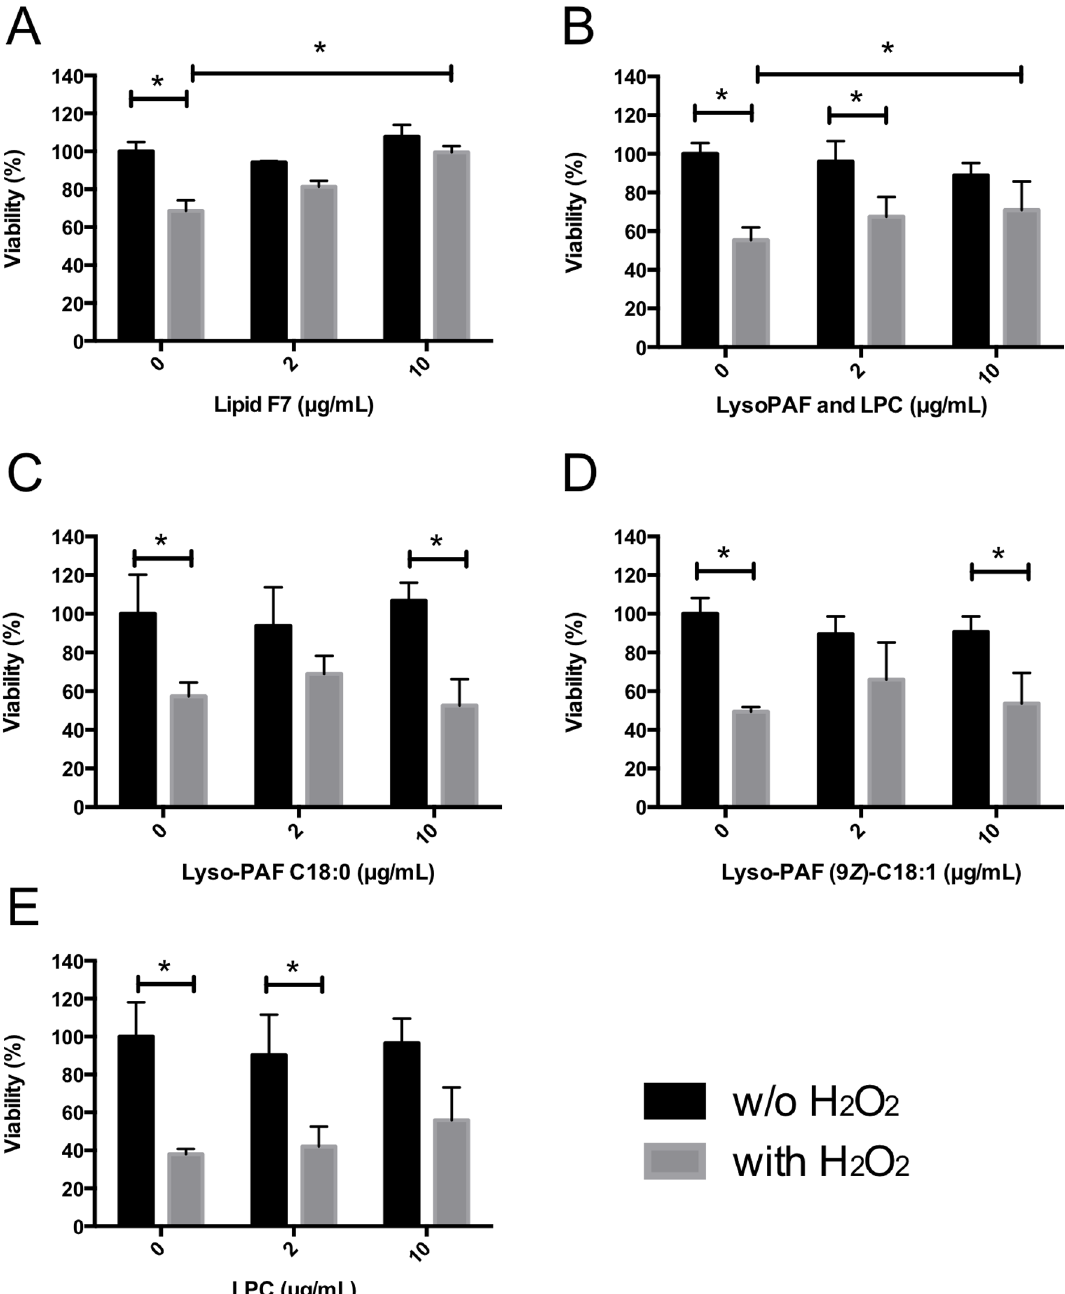
Fig 5. Viability of J774A.1 cells treated with LPC or Lyso-PAF. J774A.1 cells were preincubated with LPC or Lyso-PAF for 12 h, and H 2 O 2 was then added to the cells (25 μ M). After 12 h, cell viability was measured and is expressed as the mean viability ± standard deviation of triplicate experiments. (A) F7 lipid fraction. (B) Lipid mixture containing Lyso-PAF C18:0 (44%), Lyso-PAF (9 Z )-C18:1 (44%), and LPC C18:0 (12%). (C) Lyso-PAF C18:0. (D) Lyso-PAF (9 Z )-C18:1. (E) LPC. ( * ) Significant ( P < 0.05) according to ANOVA followed by Tukey ’ s multiple